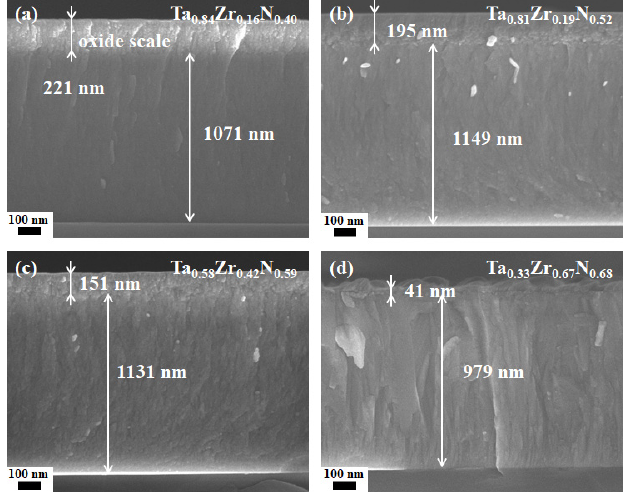
Figure 6. Cross ‐ sectional SEM images of the Ta–Zr–N thin films after annealing at 600 °C in 15 ppm O 2 ‐ N 2 for 8 h. ( a ) Ta 0.84 Zr 0.16 N 0.40 ; ( b ) Ta 0.81 Zr 0.19 N 0.52 ; ( c ) Ta 0.58 Zr 0.42 N 0.59 ; ( d ) Ta 0.33 Zr 0.67 N 0.68 .